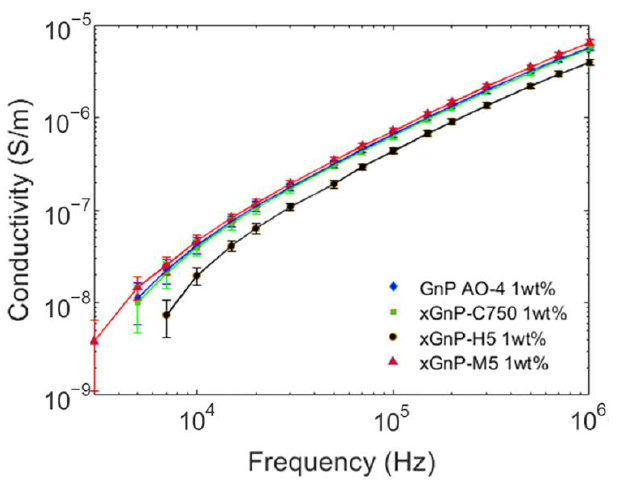
Figure 2. Electrical conductivity of epoxy/GNP nanocomposites containing different grades of GNPs at 1 wt% loading.